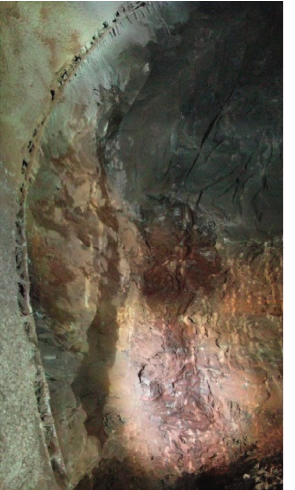
Figure 9: The actual contour at DK247 +033.5.